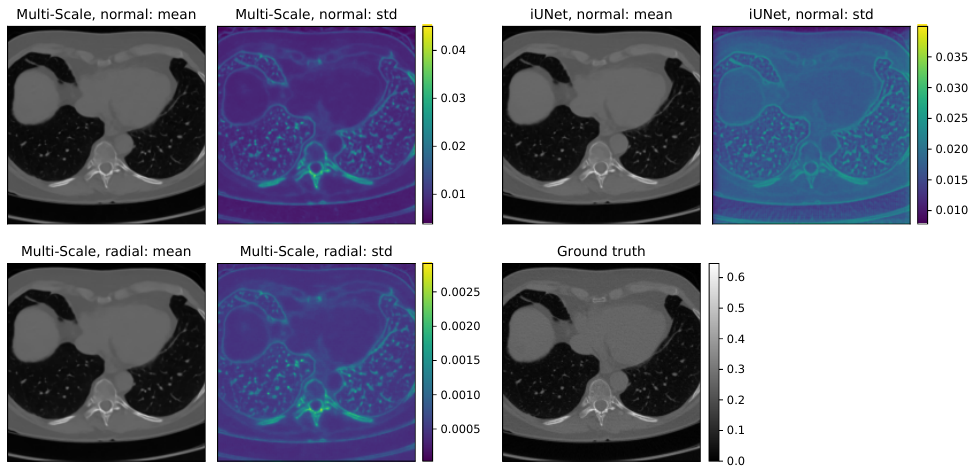
Figure 8. Cond. mean and point-wise standard deviation for the iUNet and the multi-scale architec- ture on the LoDoPaB-CT